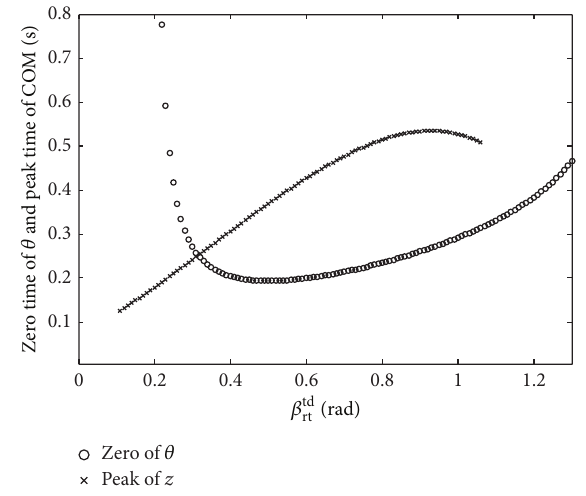
Figure 10: The zero time of pitching angle and the peak time of